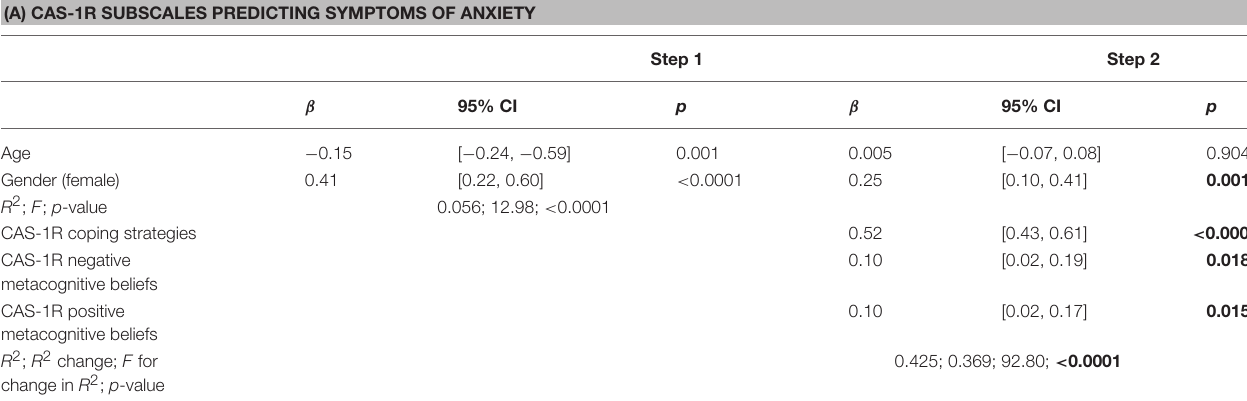
TABLE 6 | Cognitive Attentional Syndrome Scale-1 Revised (CAS-1R) subscales predicting anxiety and depression symptoms, after controlling for age and gender. (A) CAS-1R SUBSCALES PREDICTING SYMPTOMS OF